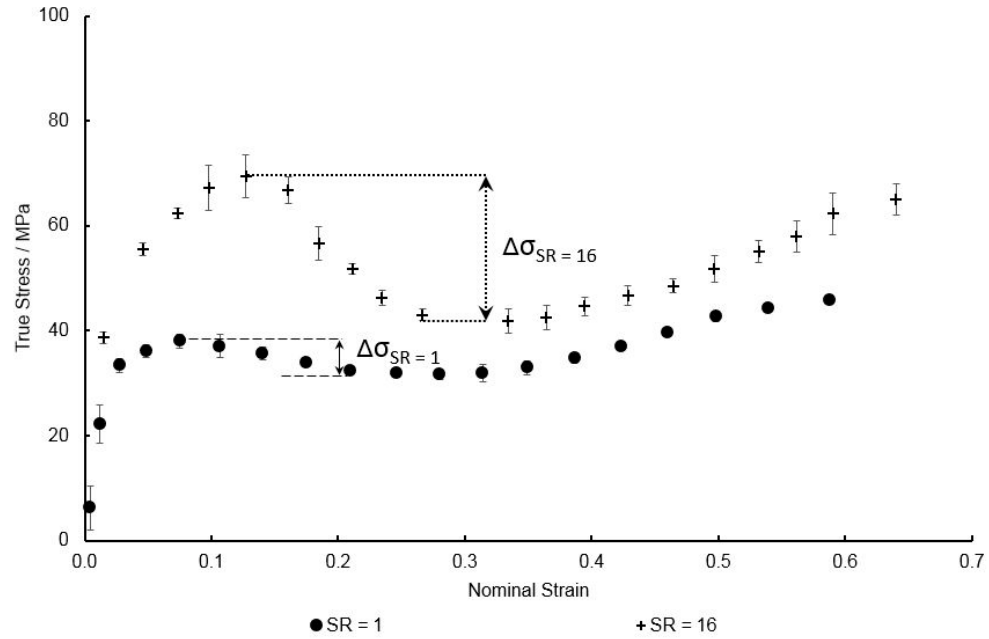
Figure 10. Observed variation drop in post-yield stress with increasing strain rate at a temperature of 130 °C.